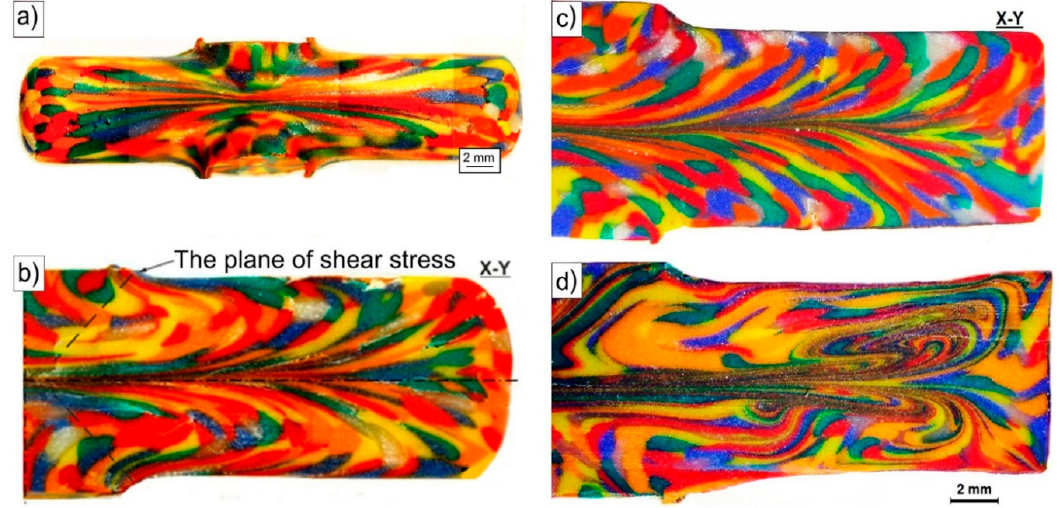
Figure 6. Modeling clay samples after: ( a ) One pass of CCE without BP and ( b ) cross-section of vertical-longitudinal samples and also ( c ) with back pressure—1 × CCE+BP, ( d ) 4 × CCE+BP.